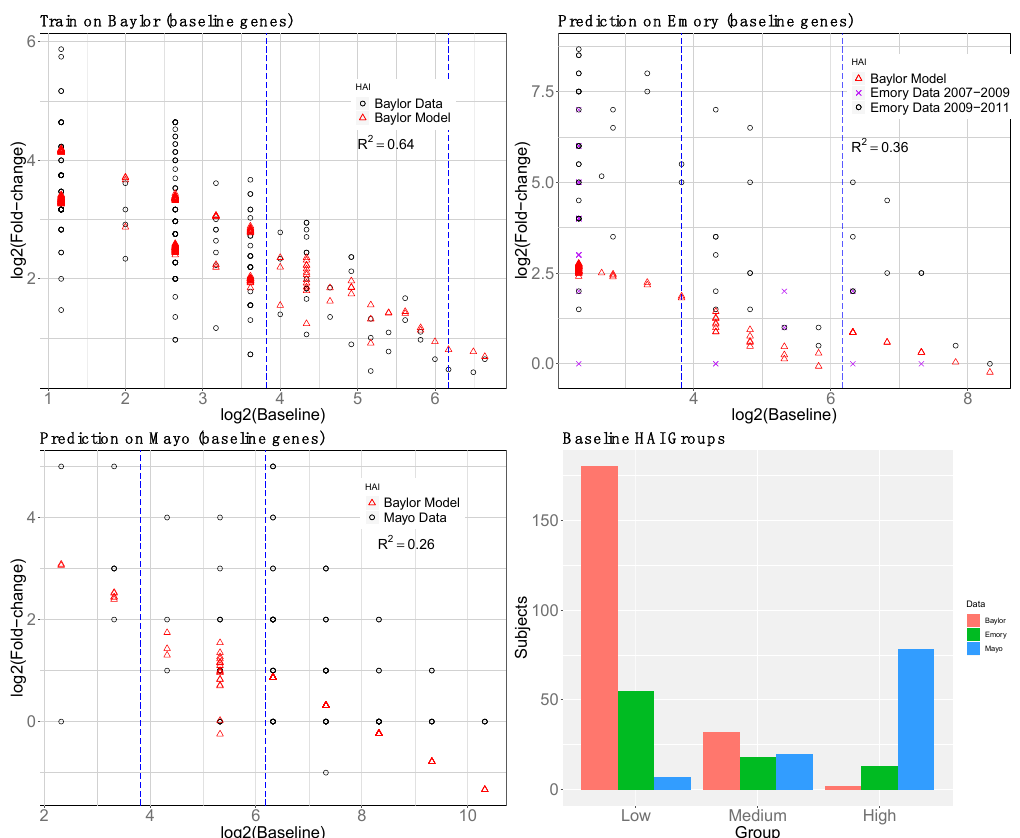
Figure 5. Second-stage (HAI plus gene expression) baseline (day-0) model prediction of post-vaccination HAI fold change (day 28). Genes were selected by reGAIN from baseline in nested cross-validation to predict the residual HAI fold change from the pre − vaccination HAI model (Figure 2). The model was trained on Baylor data (upper left). The black circles show the original data, and the red-triangles show the predicted outcome. The Emory prediction (upper right) consists of two data sets distinguished by black circles and purple x’s. The validation R 2 is shown for each prediction. The barplot shows the number of subjects in each day-0 HAI titer group.